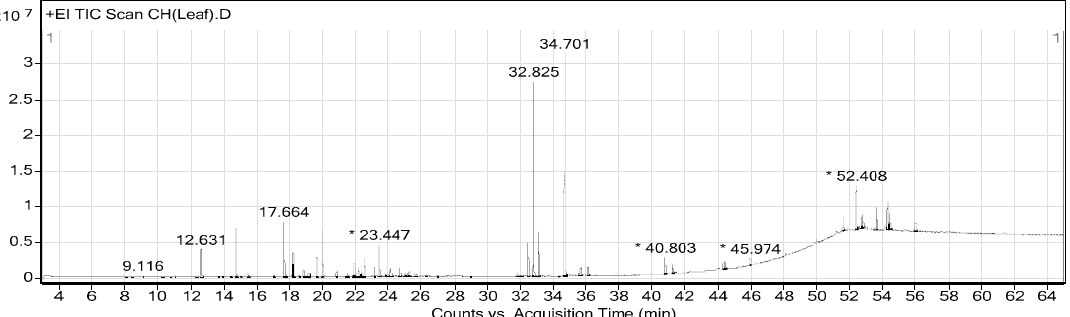
Figure 2. GC-MS chromatogram of Citrus hystrix leaves (CHL). * Peaks of proposed phytochemical constituents in CHL were suggested by GC-MS. Table 4. Proposed phytochemical constituents in Citrus hystrix peels (CHP) compared with the National Institute of Standards and Technology (NIST) database. Peak